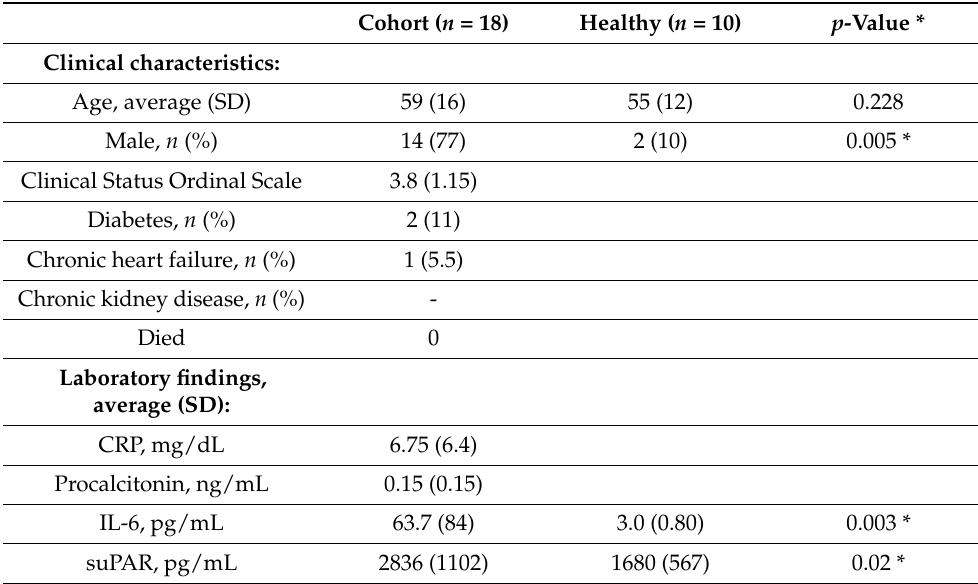
Table 1. Clinical characteristics and laboratory data of the Cohort including eighteen COVID-19 patients hospitalized in the Infectious Diseases Unit during Italian second wave and compared to ten healthy